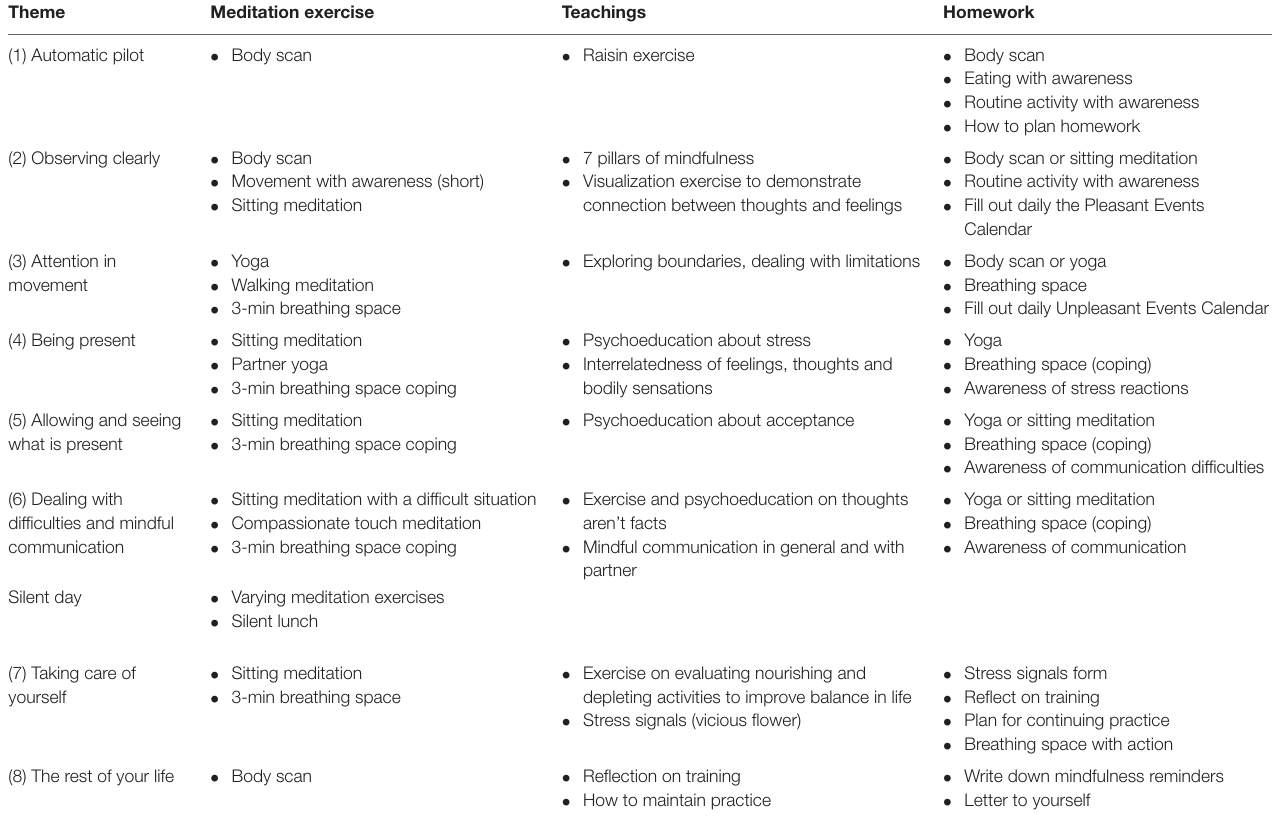
TABLE 2 | Content of the TANDEM program per session.